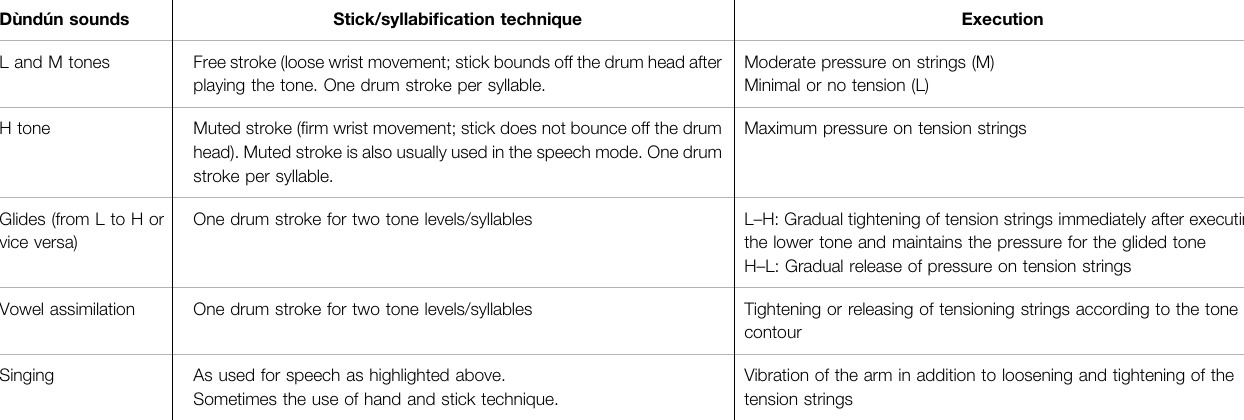
TABLE 1 | Characteristics of various techniques, execution, and sound types produced on the dùndún drum. Dùndún sounds Stick/syllabi fi cation